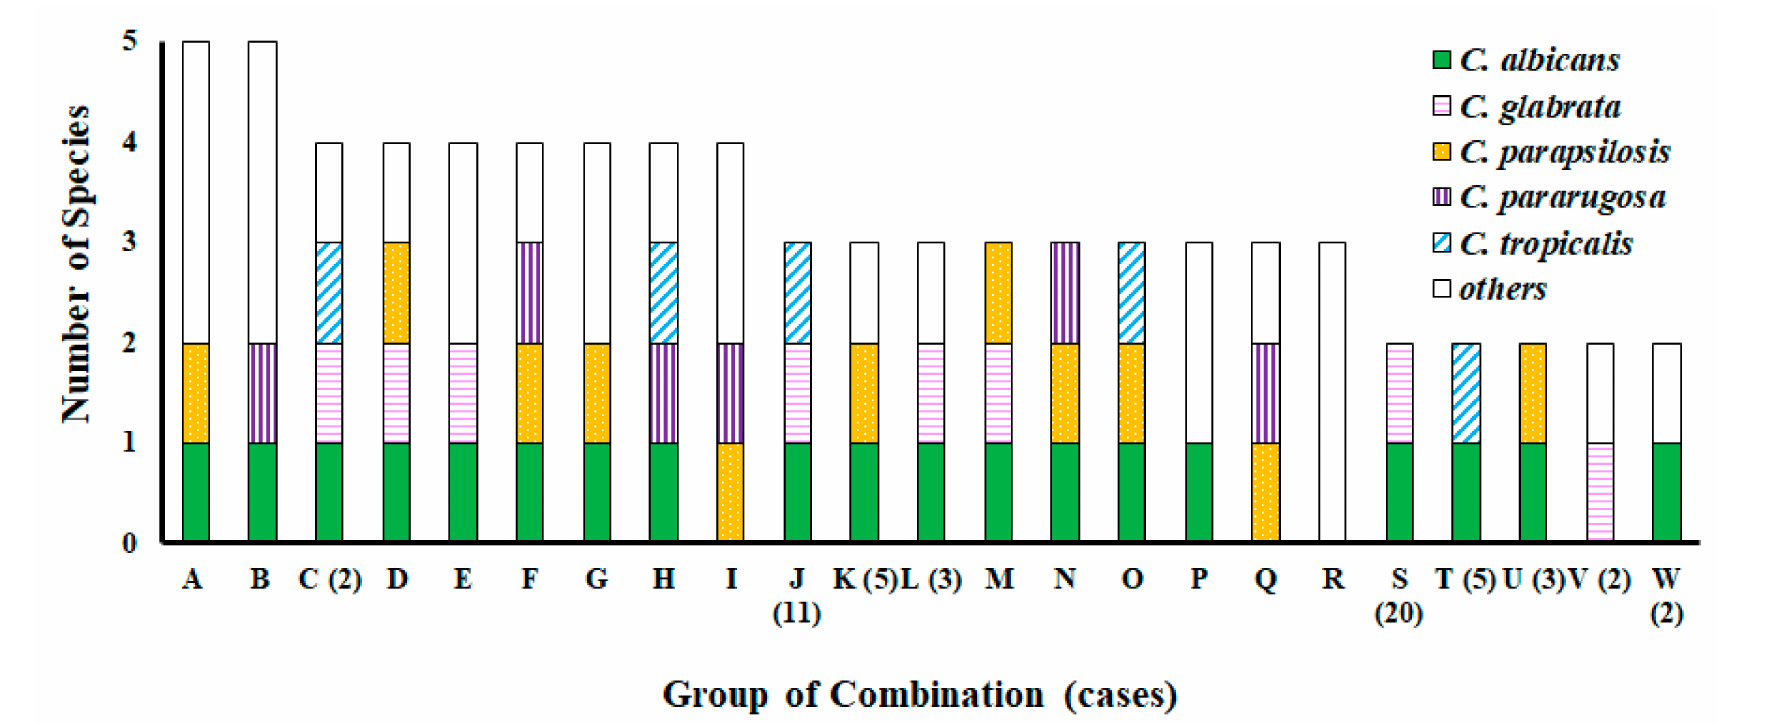
Figure 2. Distribution of species composition of residents colonized by multiple species. The number in parentheses refers to the number of the combination of species. Where a number is not given, there was only one case in the